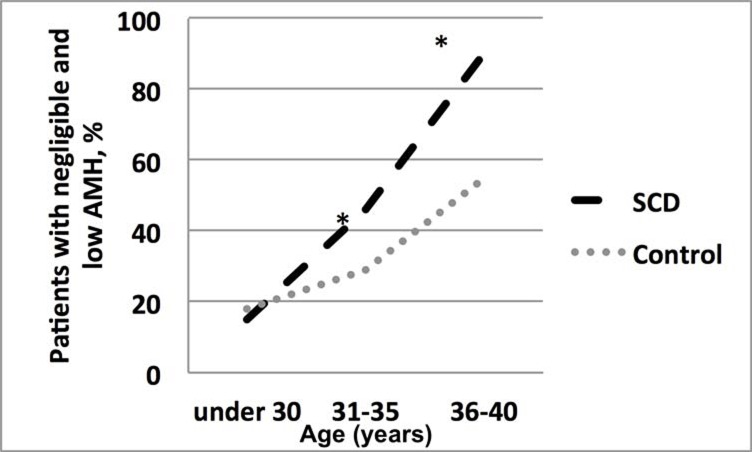
Prevalence of patients with negligible (<1.5 pmol/l) and reduced (1.5–6.5 pmol/l) AMH among SCD and control patients (* p≤0.5).